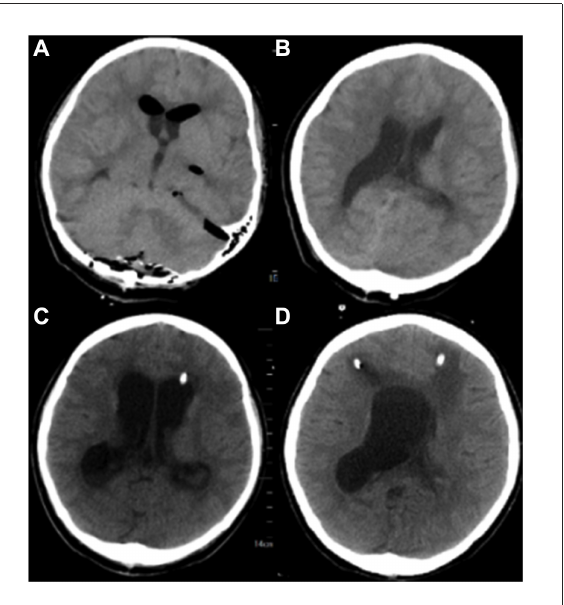
FIGURE2 Brain CT of the patient in different stages of the disease. (A, B) : Postoperative CT of the patient. (C) On the 17th postoperative day, the patient’s head CT after left ventriculocentesis. (D) On the 27th postoperative day, the patient’s head CT after left